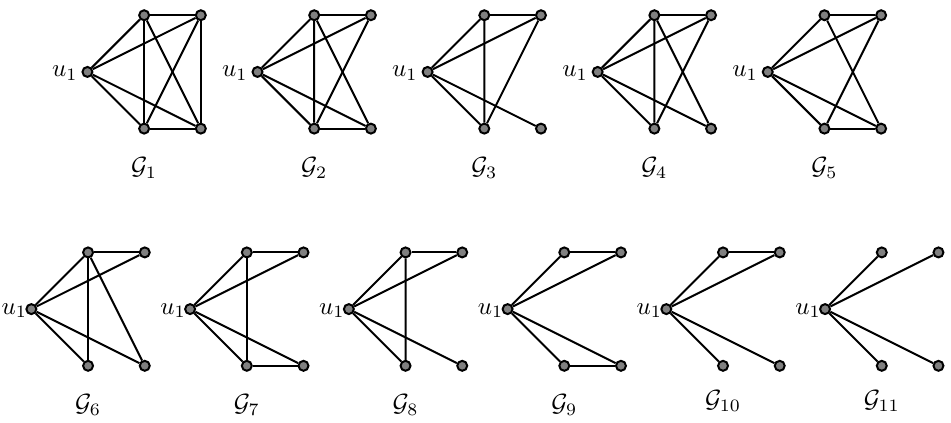
Figure 2: Graphs of order five with a dominating